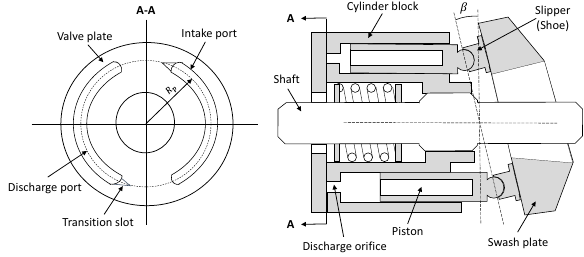
Figure 5: Schematic of an axial piston pump